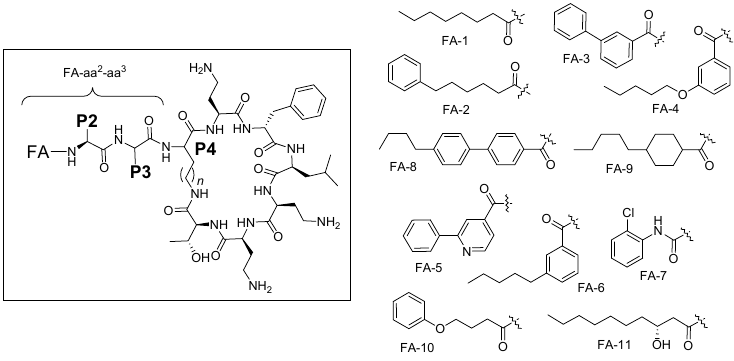
Figure 2. General structure of polymyxin B nonapeptides and fatty acyl tails used in this study.